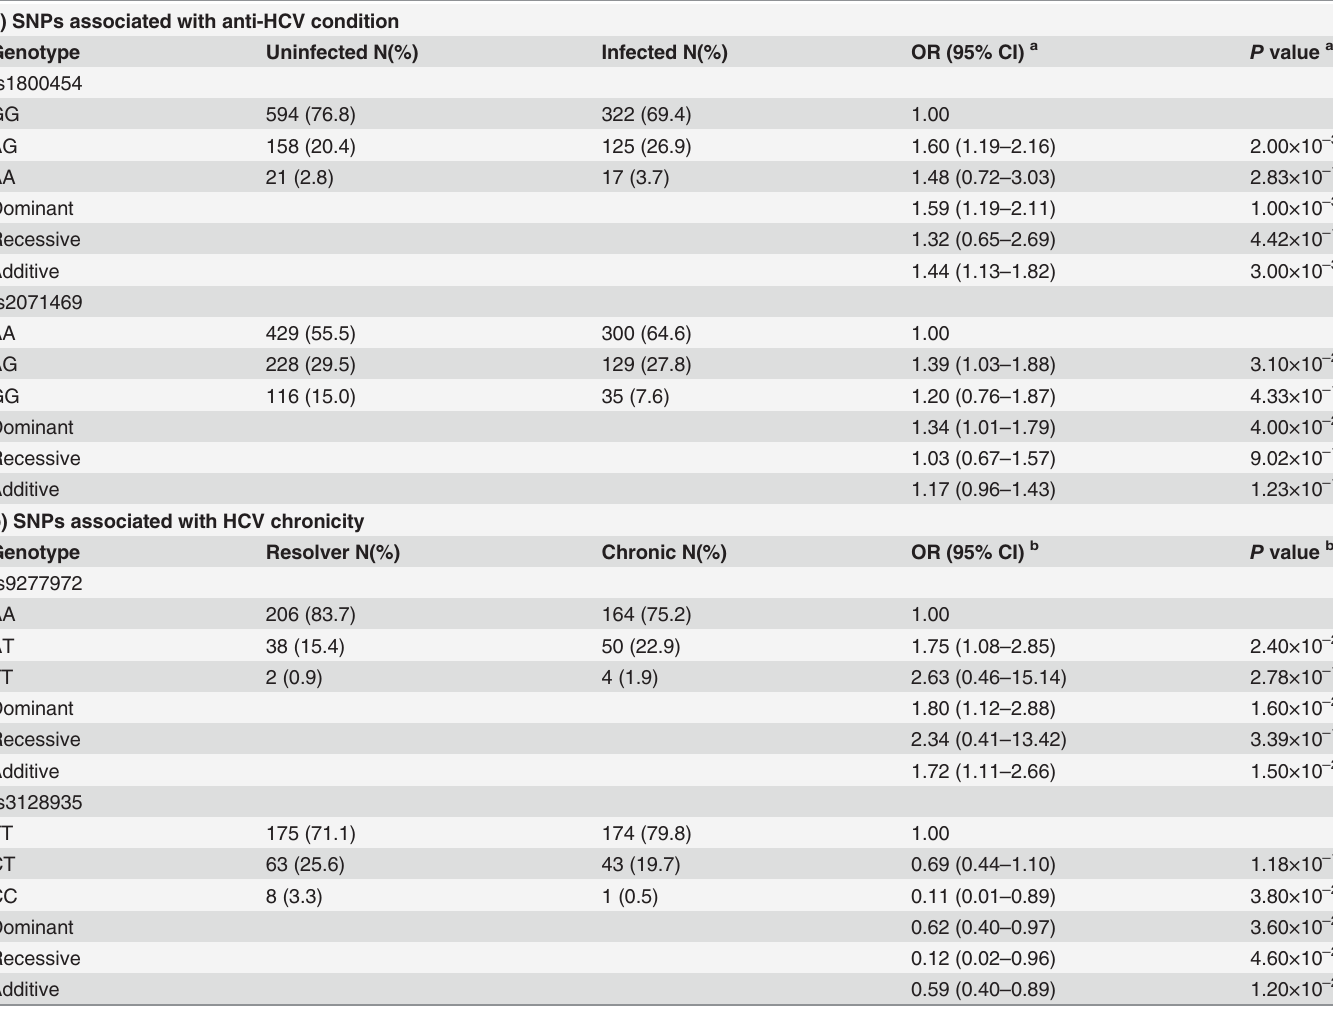
Table 2. Association of selected SNPs with HCV infection